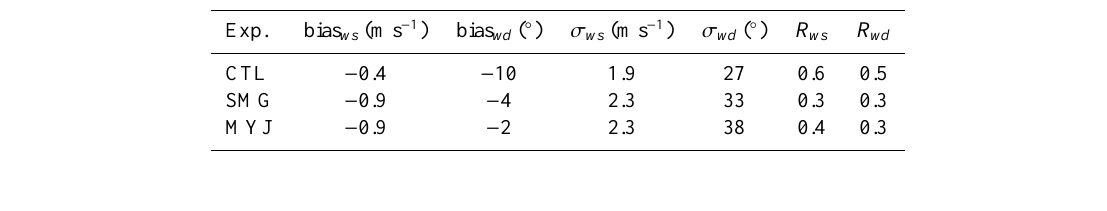
Table 1. Bias (WRF-ASAR), standard deviation σ and correlation coe ffi cients R of wind speed ( ws ) and direction ( wd ) for the di ff erent experiments after resampling at 0.05 ◦ by 0.05 ◦ . Section 4 explains the characteristics of the di ff erent experiments.